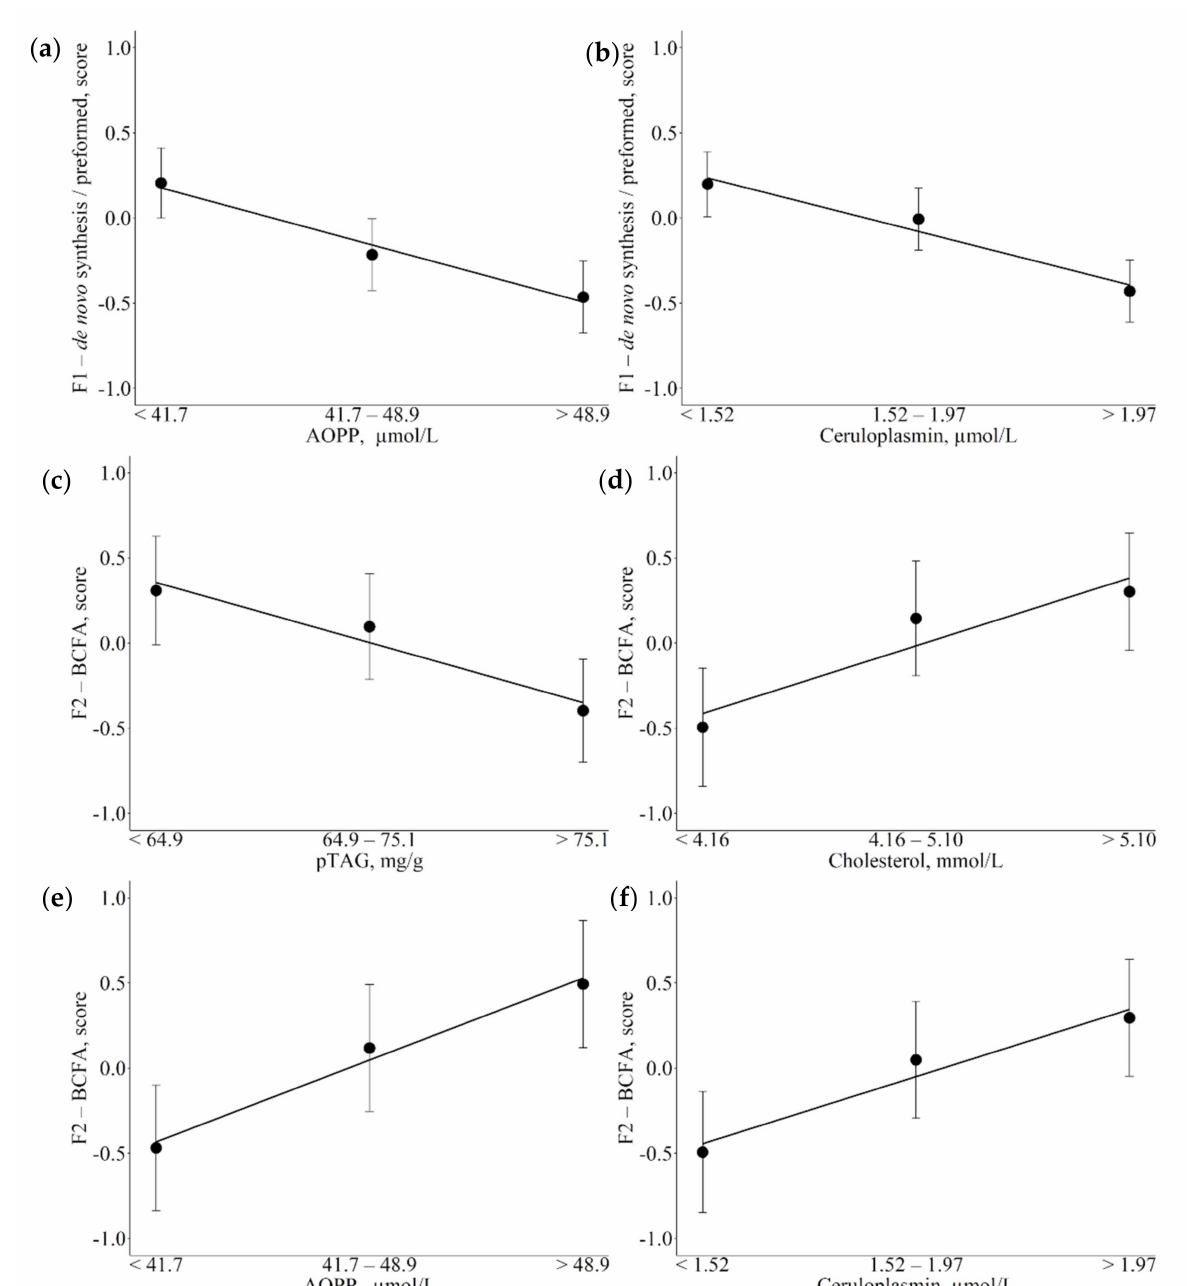
Figure 1. Least square means (LSM) for F1-de novo synthesis/preformed ( a , b ) and F2-branched chain fatty acids (BCFA; ( c – f )) across the traits of concern. ( a,e ): advanced oxidation protein products (AOPP); ( b , f ): ceruloplasmin; c: predicted liver triacylglycerol (pTAG); ( d ): cholesterol. Black dots indicate the LSM and error bars indicate the standard error. Trendlines define linear or quadratic pattern according to polynomial contrast calculations ( p <